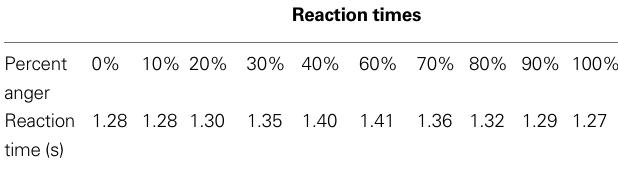
Table 1 | Reaction times for each morph